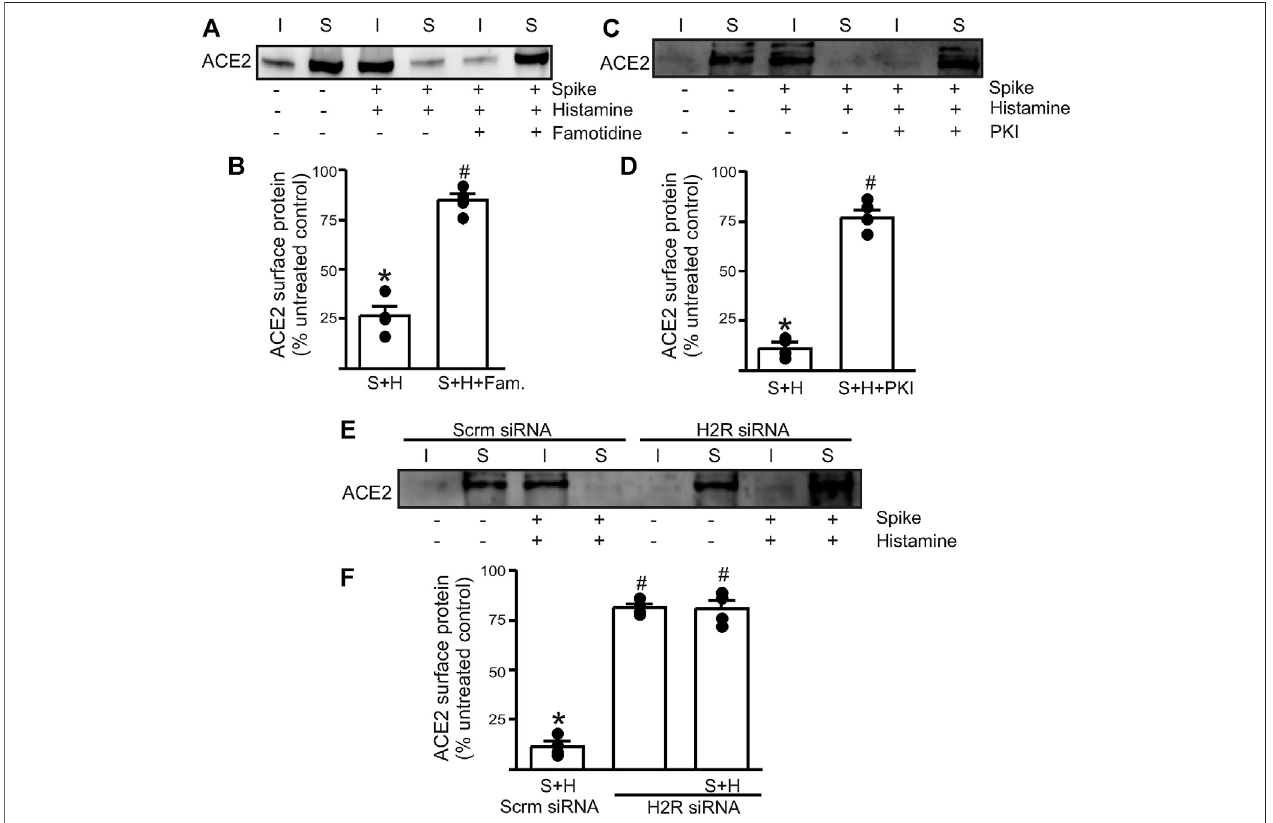
FIGURE 2 | Histamine H2 receptor signaling is involved in histamine potentiating spike – ACE2 internalization. (A) Representative Western blot after surface biotinylation of the intact endothelial cells showing the effect of famotidine on the potentiating effect of histamine on spike-ACE2 internalization. (B) Mean data. (C) Representative Western blot after surface biotinylation showing the effect of the protein kinase A inhibitor, PKI, in preventing histamine-induced spike – ACE2 internalization. (D) Mean data. * p < 0.05 vs . the untreated control, # p < 0.05 vs . spike + histamine. (E) Representative Western blot after surface biotinylation showing the effect of H2 receptor protein knockdown on spike + histamine treatment. Scrm-scrambled siRNA. (F) Mean data. * p < 0.05 vs . untreated control, # p < 0.05 vs . spike + histamine scrambled control. n = 4 for all the experimental sets. I- indicates intracellular fraction, S-denotes surface or plasma membrane fraction.